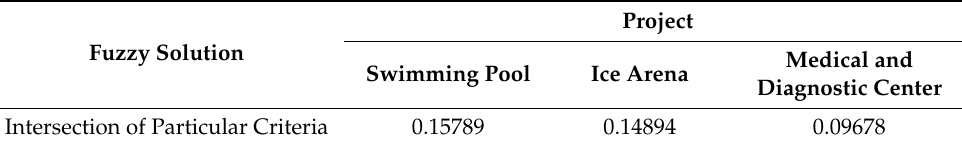
Table 7. Solution evaluation